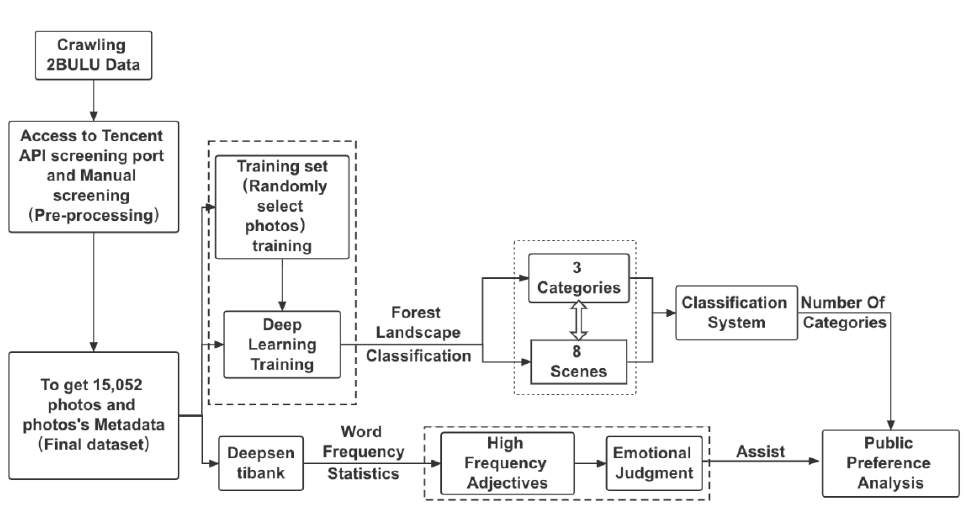
Figure 2. Research